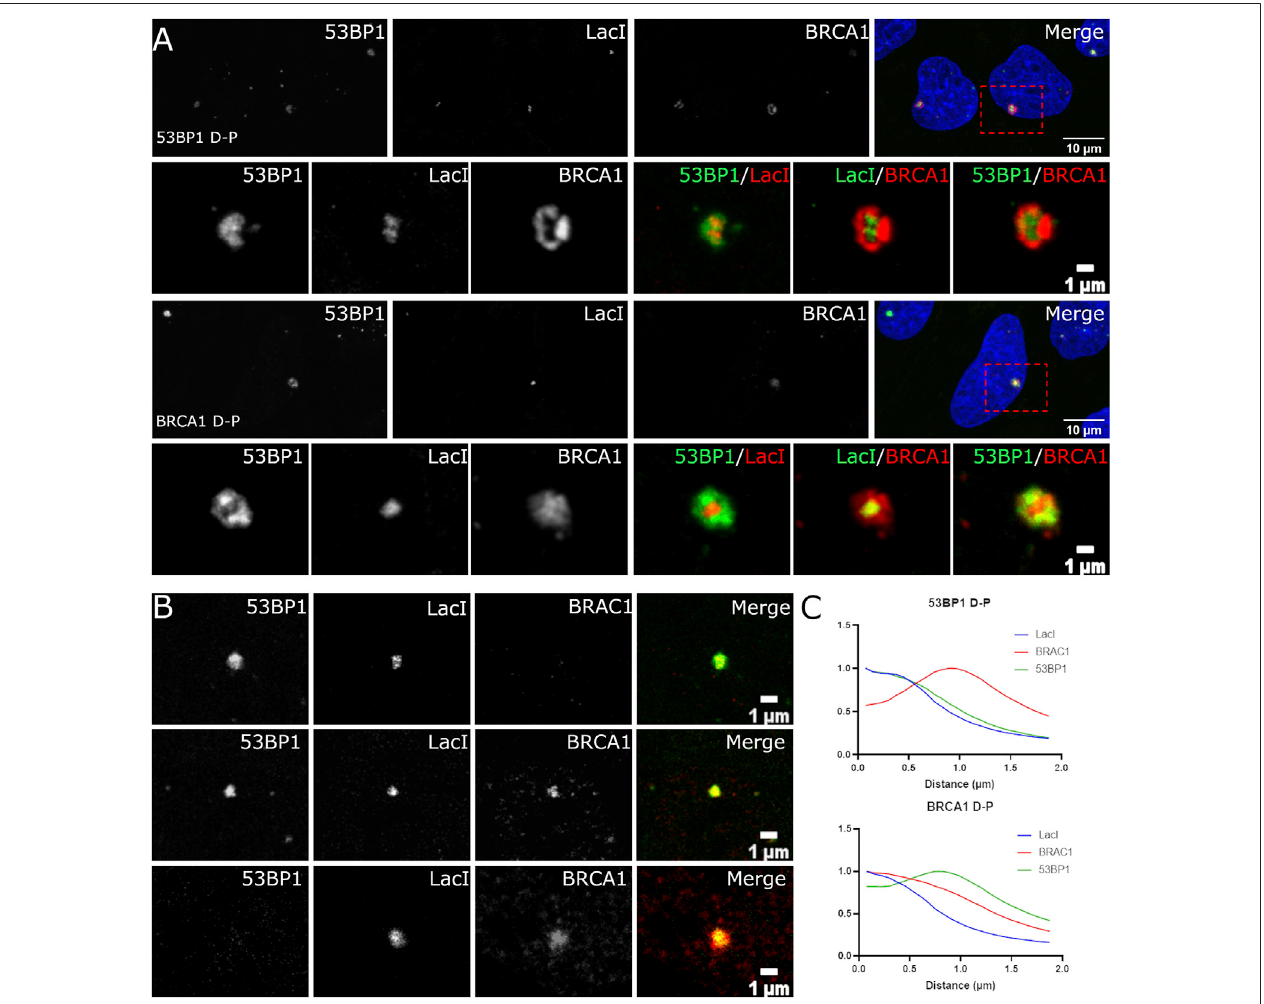
FIGURE4| Localization ofBRCA1and 53BP1 relativetothe siteof thedamaged DNA. (A) U2OS 265cells were fi xed 1 h post-treatmentwith4-OHT and Shield1 to induce DSB formation and then immune stained with 53BP1 and BRCA1. Examples of 53BP1- and BRCA1-dominant double-positive foci are shown. The panel on thefarrightinrows1and3showthenucleuswithDAPIinblue,BRCA1inred,and53BP1ingreen.Thehighlightedregionisshownenlargedinthecorrespondingpanels underneath. (B) The foci were categorized based on the relative difference in DSB occupancy: 53BP1-dominant cell (53BP1 D), 53BP1-dominant double-positive cell (53BP1 D-P), 53BP1 – BRCA1-positive cell (D-P), BRCA1-dominant double-positive cell (BRCA1 D-P),and BRCA1-dominant cell (BRCA1 D). (C) Radial pro fi le plots of 30 DSB over three experiments reveal three overlapping distributions that differ in the centralization of BRCA1 or 53BP1. The scale bar represents 10 µm for images illustrating the nucleus (top panel) and scale bar represents 1 µm for individual breaks.